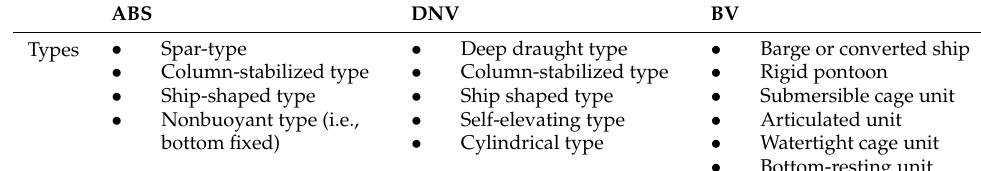
Table 1. Classi fi cation types for o ff shore fi sh farms according to ABS, DNV, and BV. Table 1. Classification types for offshore fish farms according to ABS, DNV, and BV.